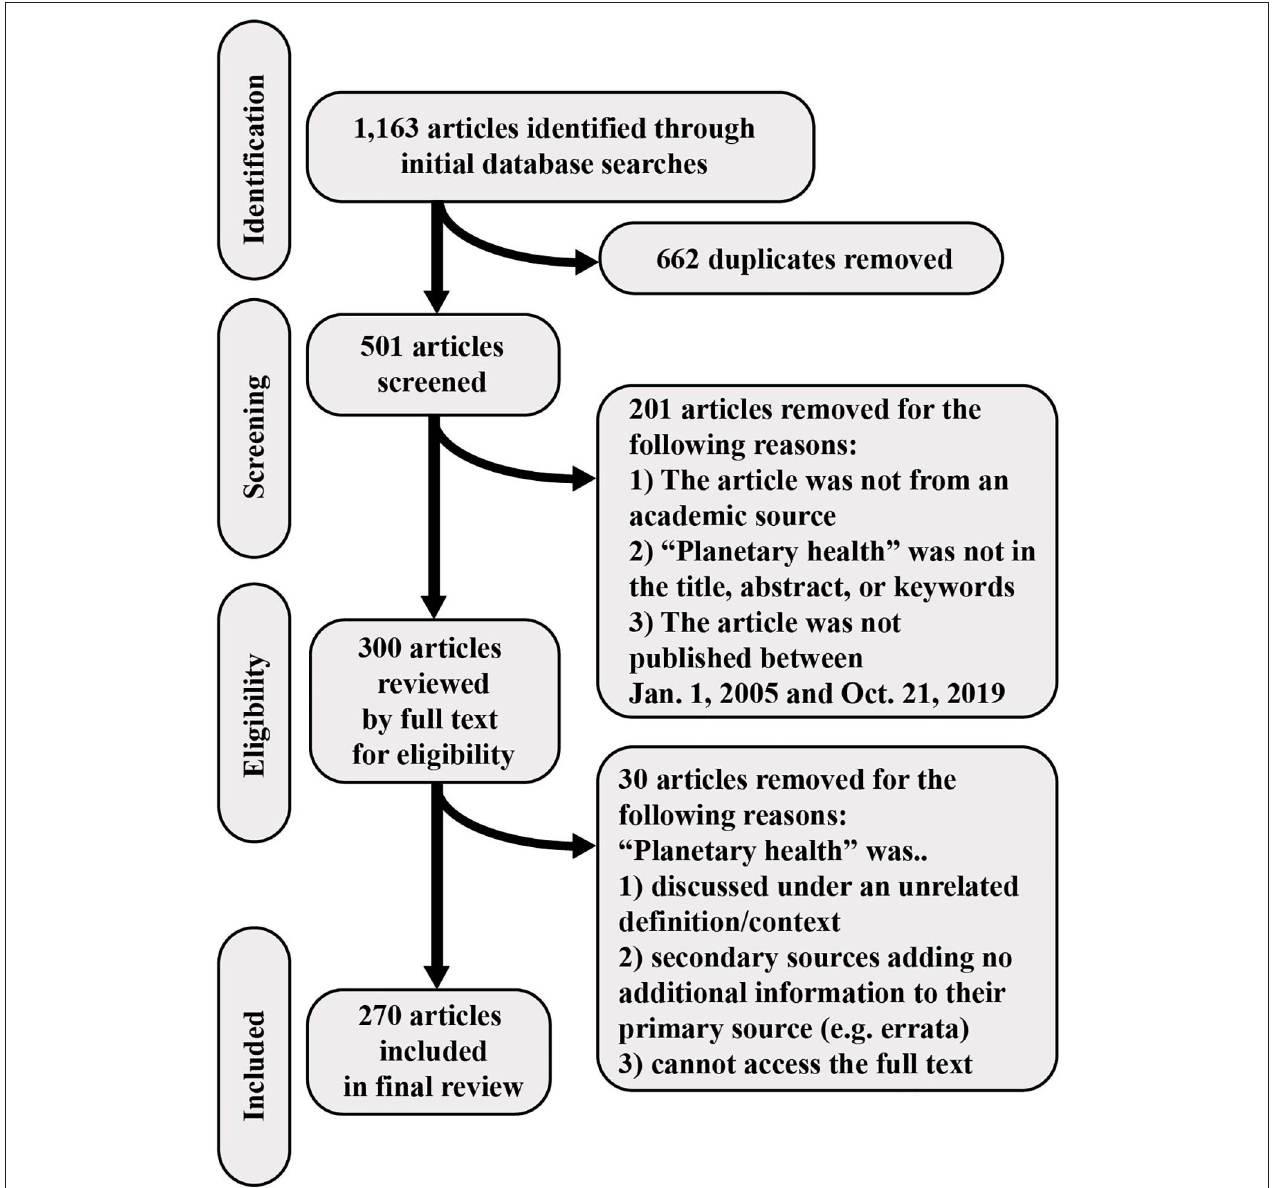
FIGURE 1 | PRISMA flow chart detailing the review process and selection of final sample of